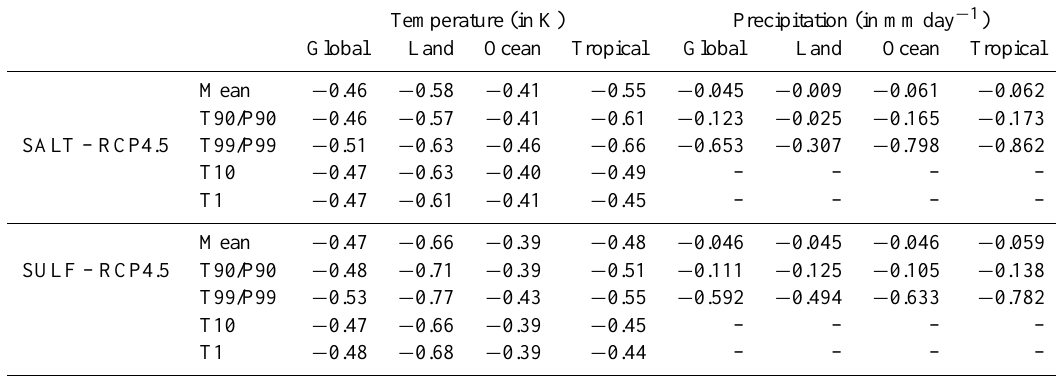
Table 6. Change in temperature and precipitation of SALT and SULF of the 2040–2069 period minus the corresponding period in the RCP4.5.